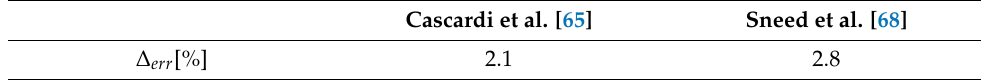
Figure 9. Comparison results for unreinforced column between the numerical and experimental curves reported in ( a ) Cascardi et al. [65] and ( b ) Sneed et al. [68]. Table 7. Results of